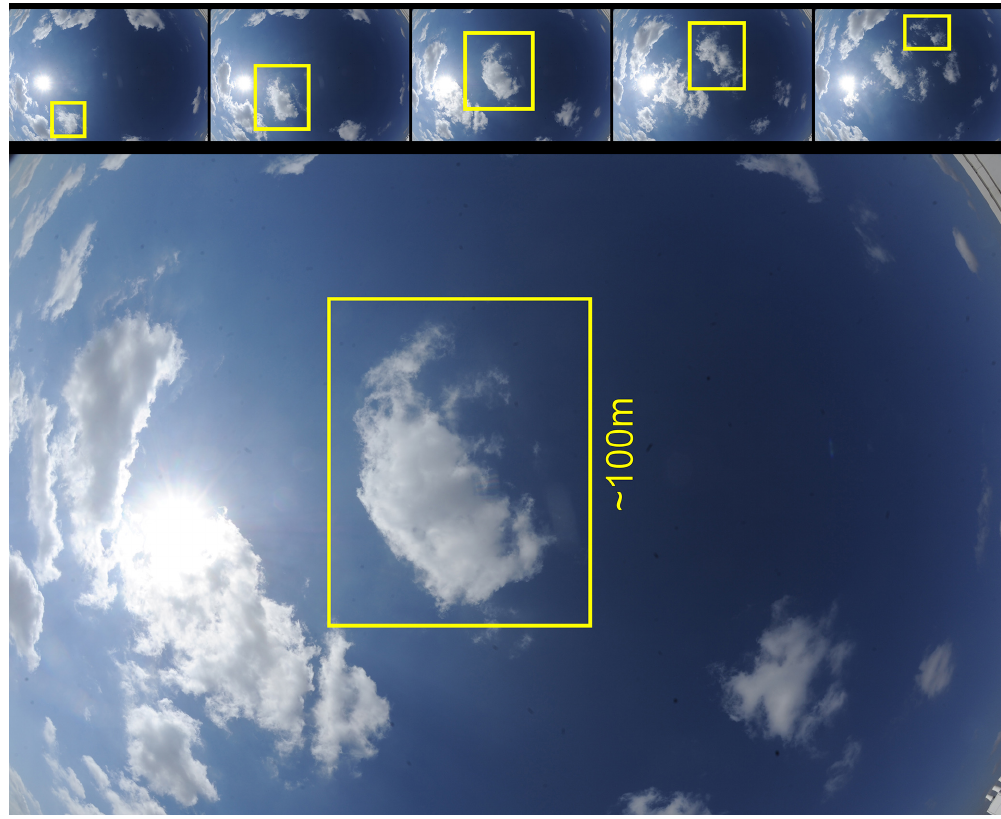
Figure 1. Images taken during a field campaign on 30 June 2011 at 15:52–15:56LT. Top: sequential (1min time lag) images of the complete lifetime of a single short-lived cloud. The camera was pointed at the zenith and the diagonal field of view is 180 ◦ . The yellow rectangles mark the position of the cloud. Bottom: enlargement of one of the